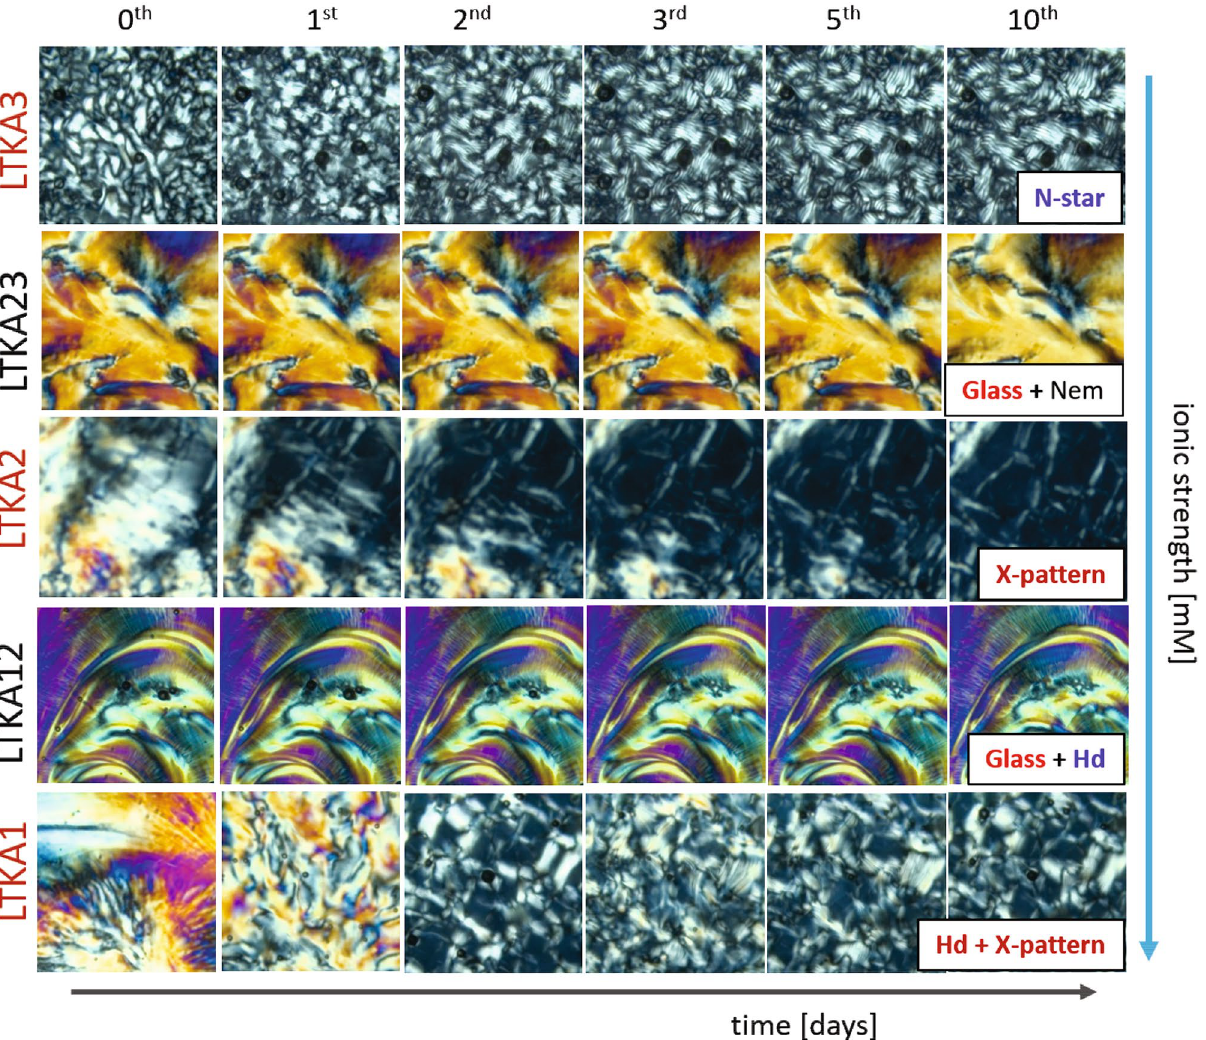
Figure 3. The long-time temporal morphologies of LTKAs in the equilibrium phase diagram: Long-time kinetic arrests are even distinguished by their rate of change in the optical morphologies, which are faster in LTKA1, LTKA2, and LTKA3, while being much slower in LTKA12, and LTKA23. The final states of the LTKAs are also only shown as clear X-patterns (in LTKA2) and the X-pattern with helical domains (in LTKA1), as well as with partial “voids”. The appearance of “voids” tends to be arbitrary in these LTKAs in the diagram. Note that LTKA3 is of a lower concentration and higher ionic strength than the other LTKAs. A software version